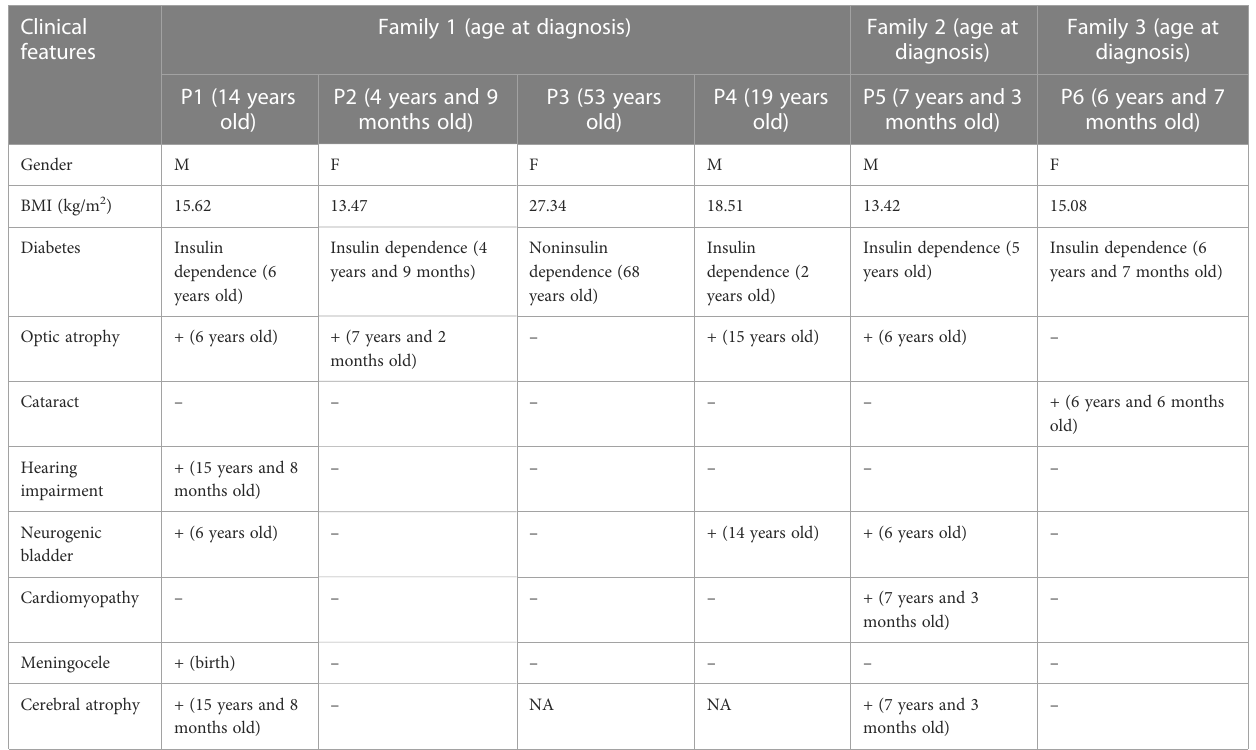
TABLE 1 Clinical phenotypic characteristics of